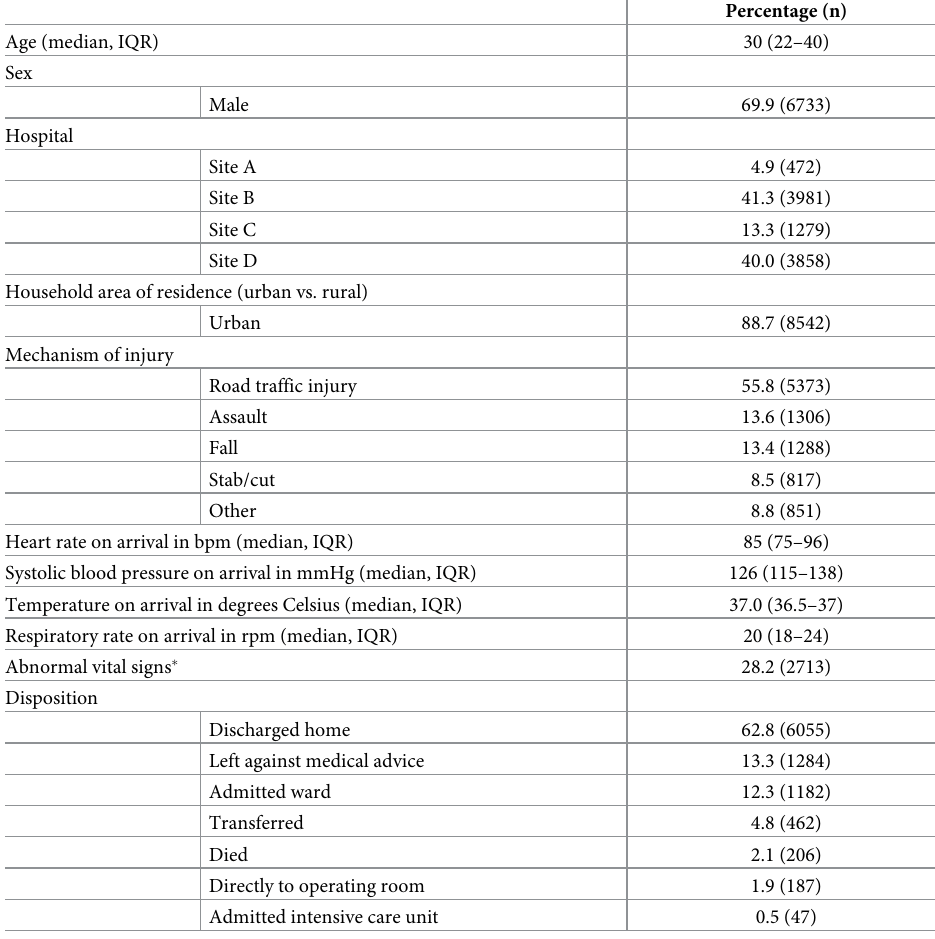
Table 1. Summary trauma population demographics (n =